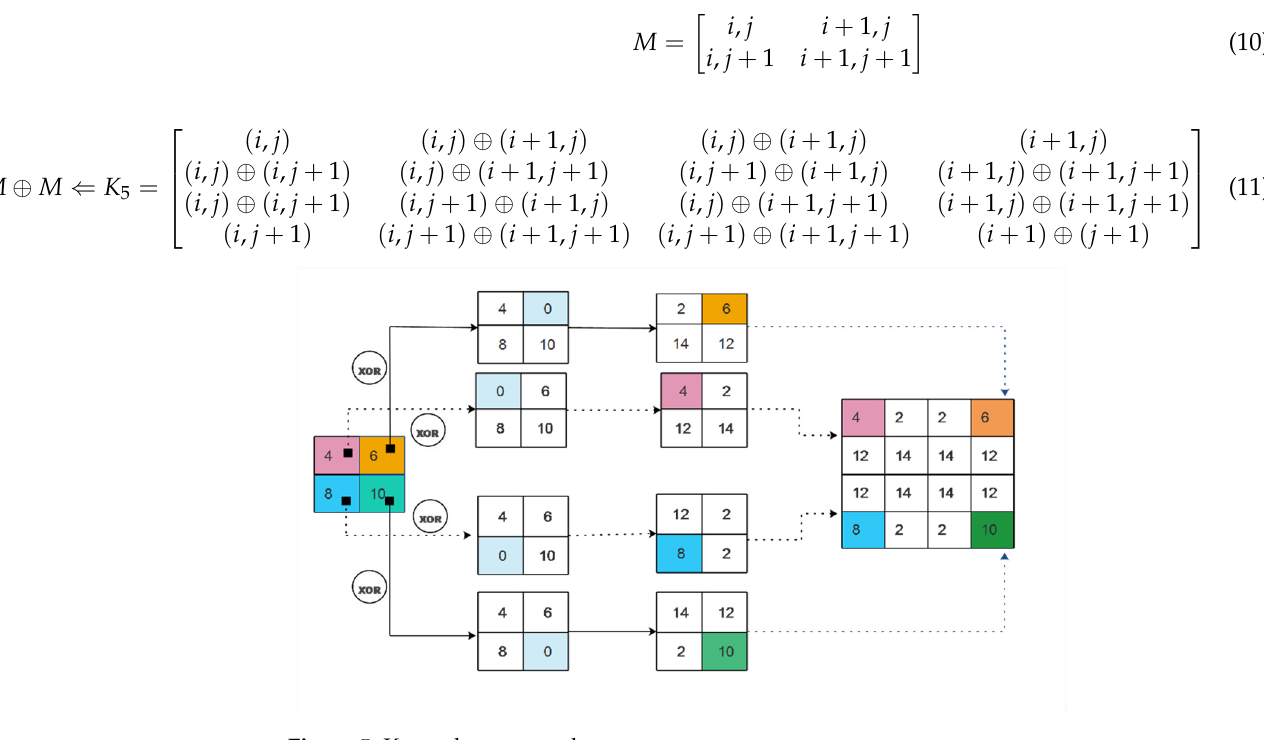
Figure 5. Kronecker xor product concept.